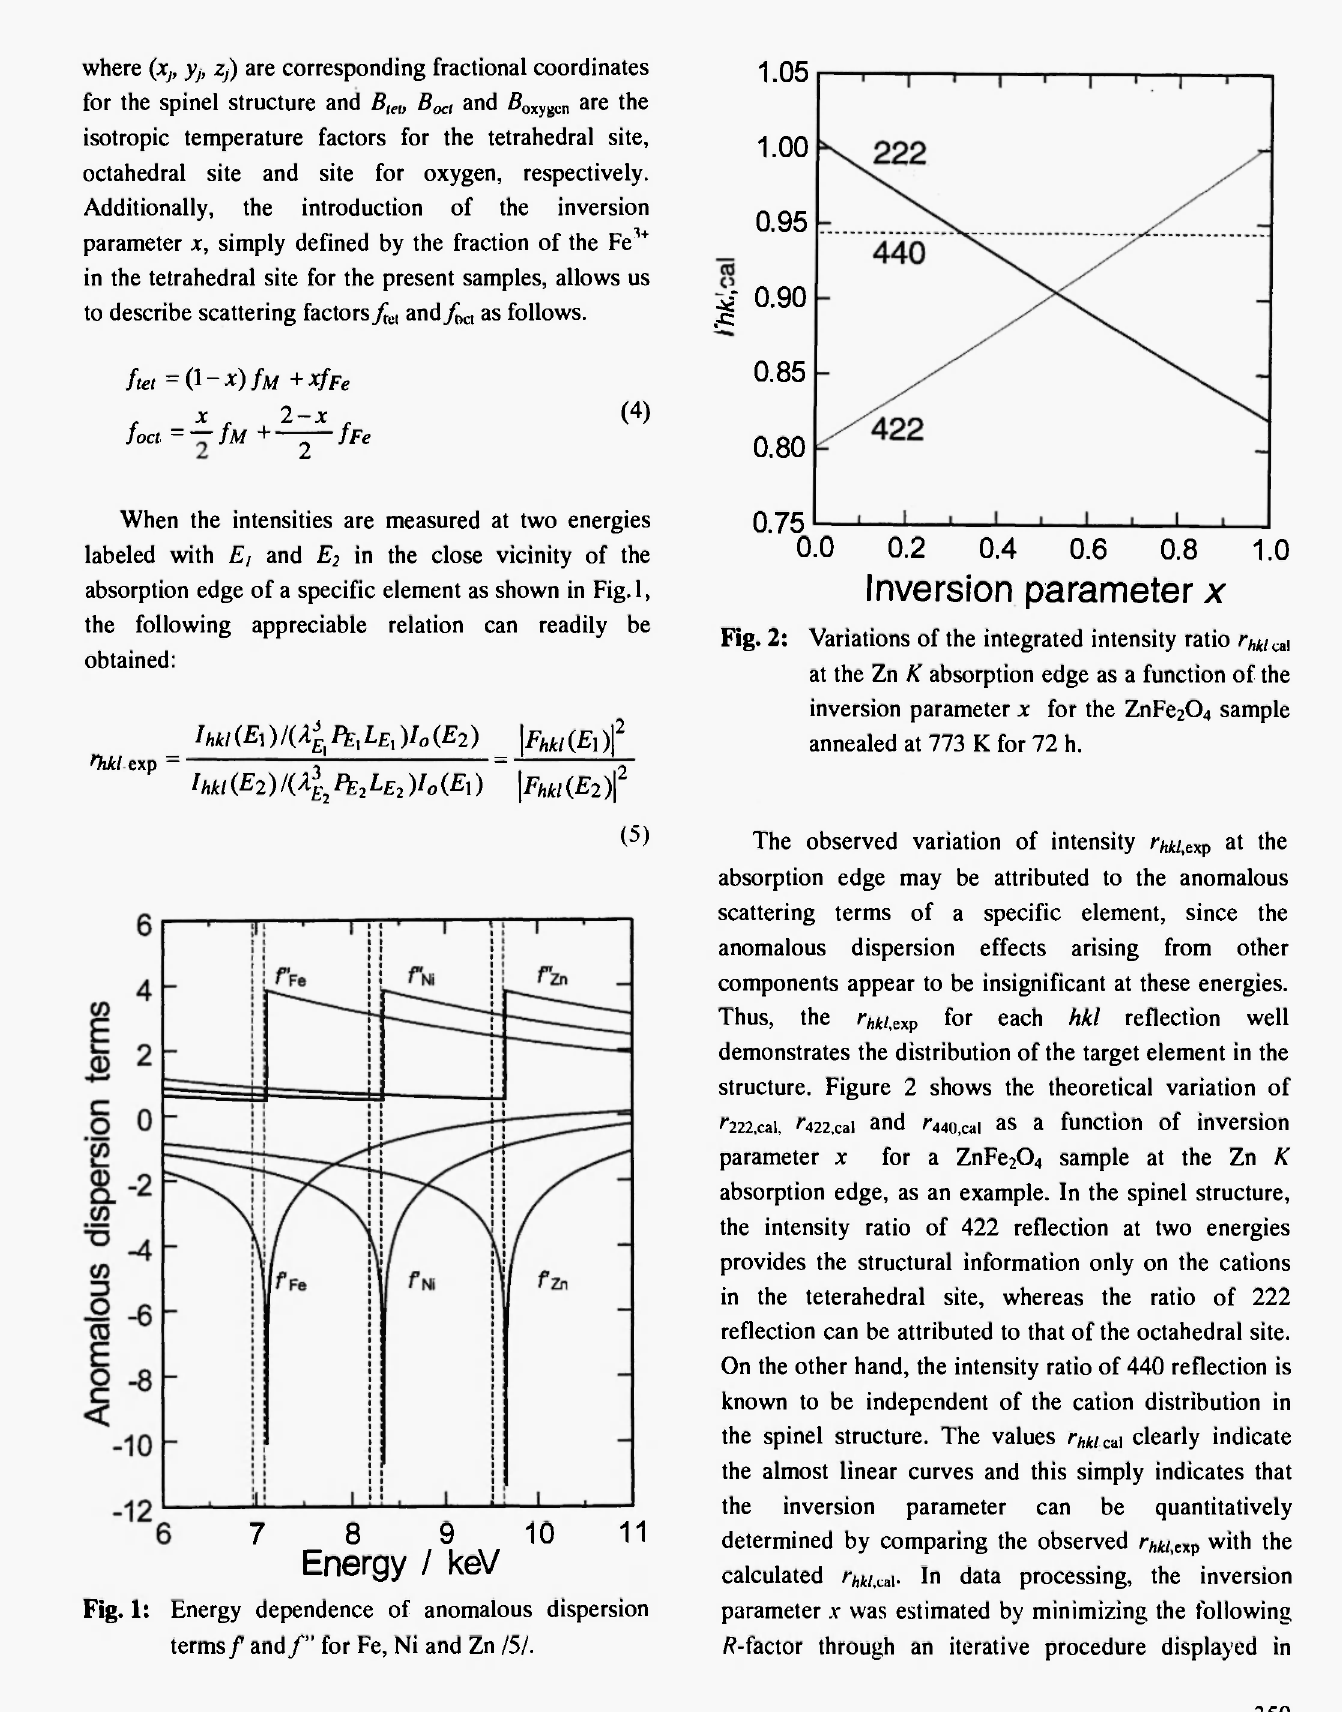
Fig. 1: Energy dependence of anomalous dispersion terms / and/" for Fe, Ni and Zn 151.